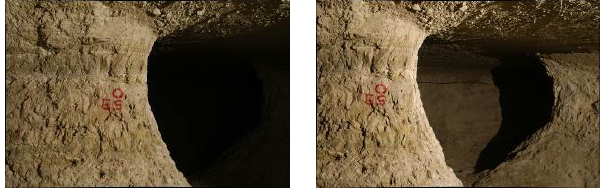
Figure 1. Consecutive images of the Tassullo cave